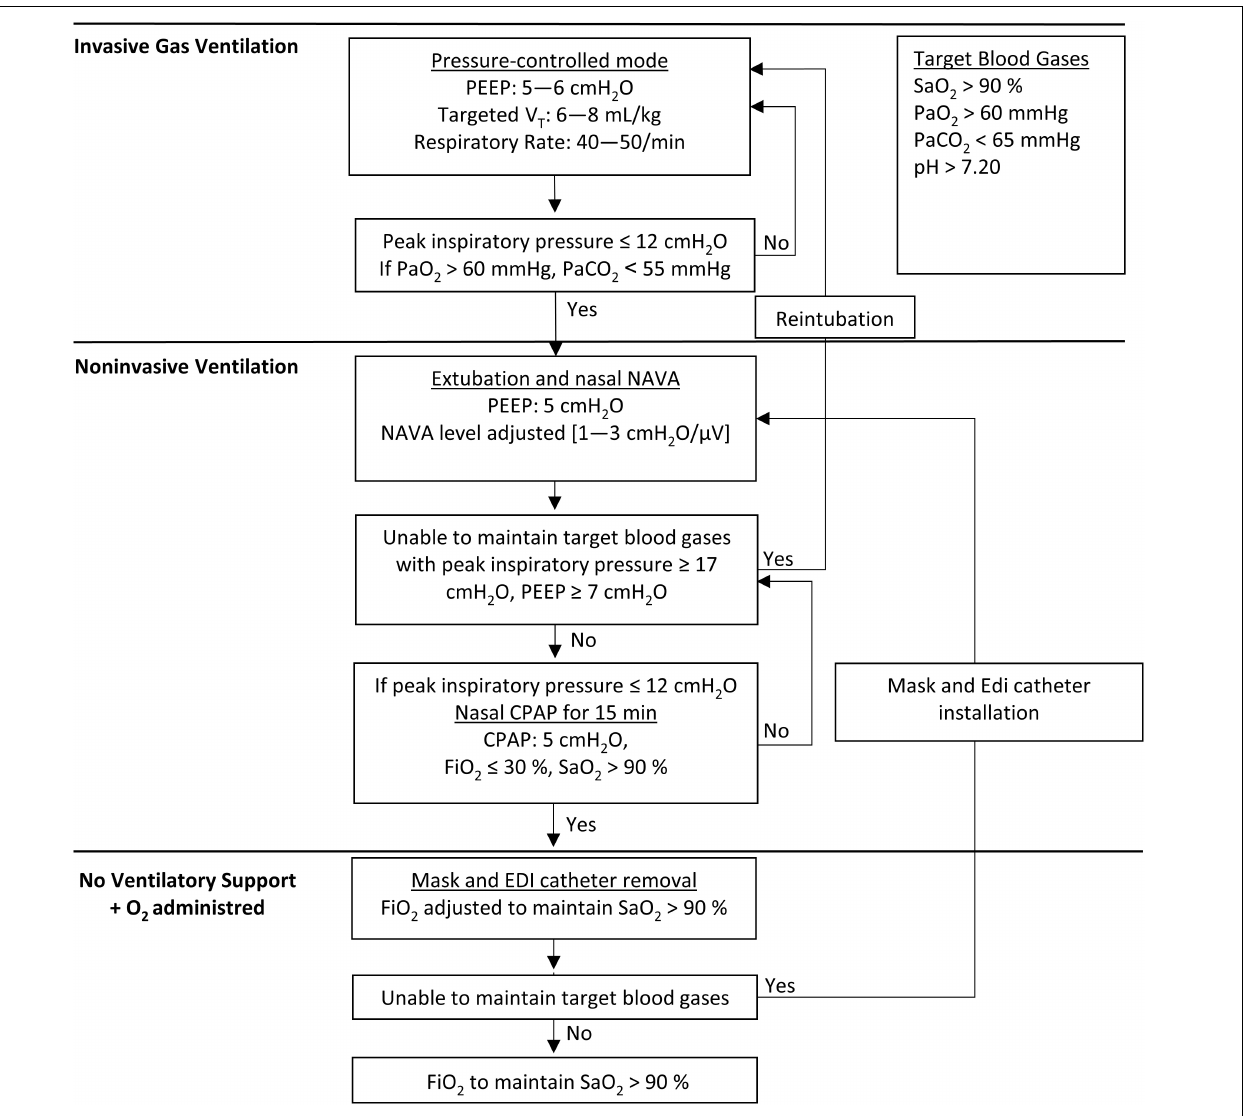
FIGURE 1 | Standardized weaning protocol after total liquid ventilation. PaCO 2 : partial pressure of carbon dioxide in arterial blood, PaO 2 : partial pressure of oxygen in arterial blood, SaO 2 : hemoglobin saturation in oxygen (pulse oximetry), PEEP: positive end-expiratory pressure, VT: tidal volume. CPAP: continuous positive airway pressure, NAVA: neurally adjusted ventilatory